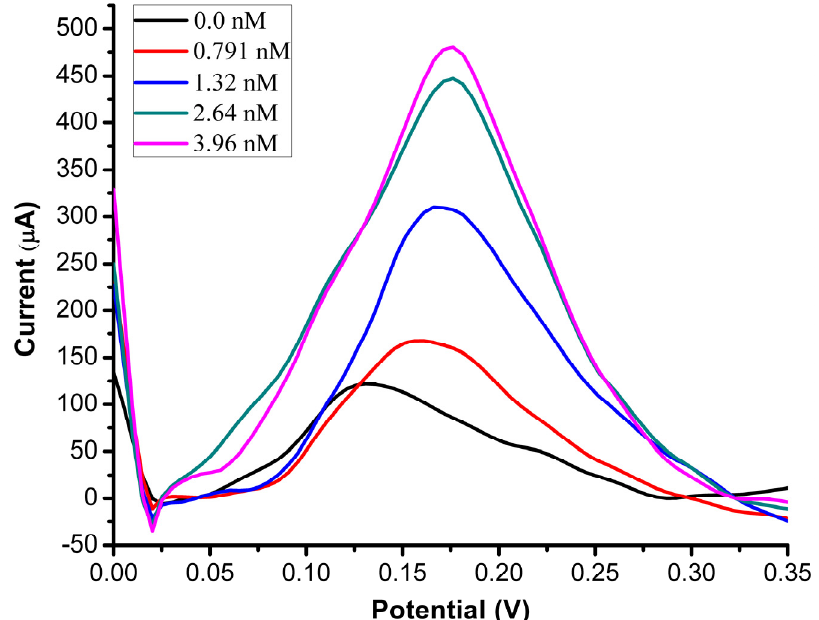
Figure 8. Voltammograms of spiked plasma samples ranging from 0.0 nM to 3.96 nM DA.